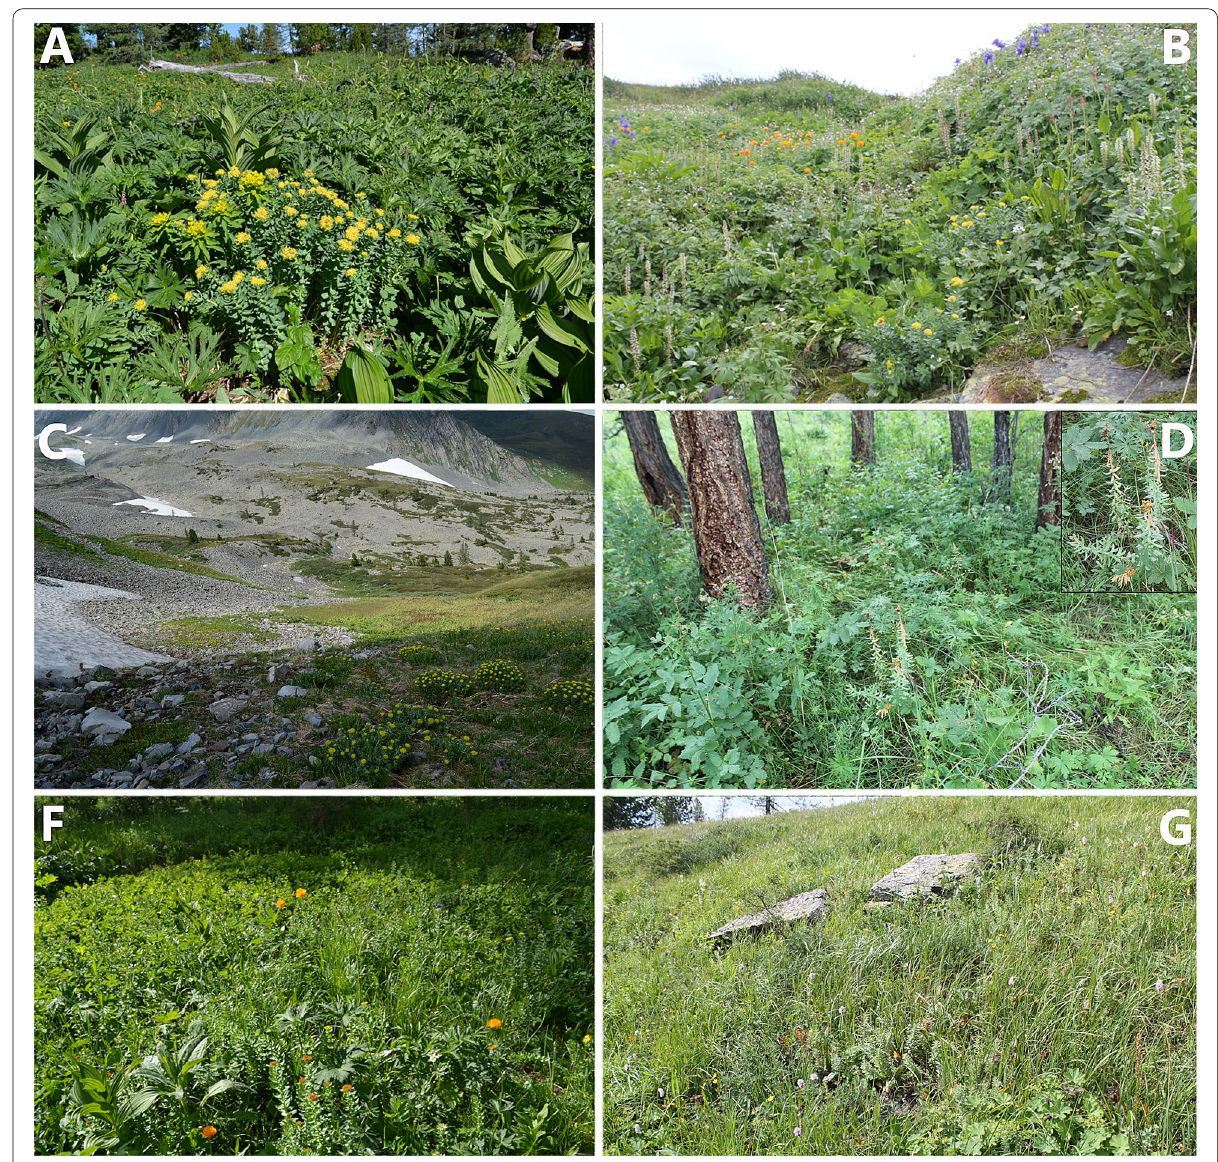
Fig. 3 Populations of R. rosea in different ecological conditions ( A in damp alpine meadows; B in shallow shallow riverbeds; C on weakly overgrown moraines near glaciers; D in cut cedar-larch forests; F in motley grass alpine meadows; G in heavily overgrown herb-grass areas (degrading